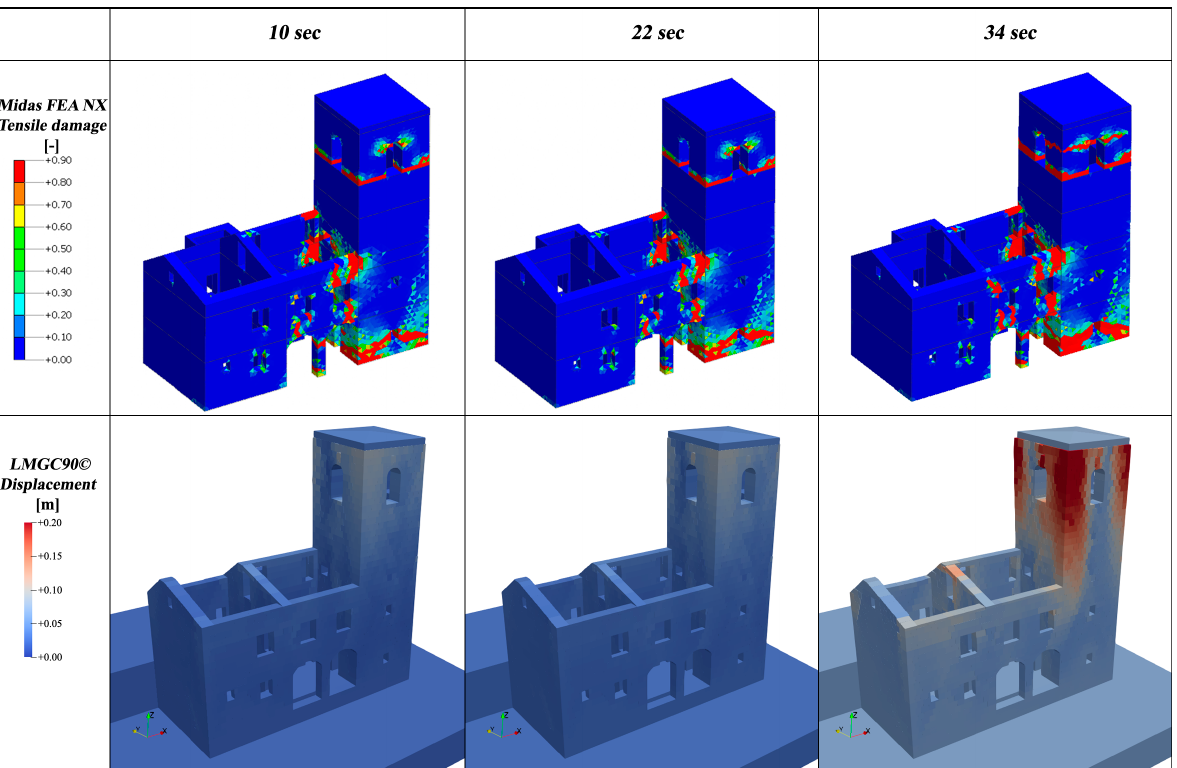
Figure 9. Damage at the end of each event in the CM (Midas FEA NX©) and DM (LMGC90©).